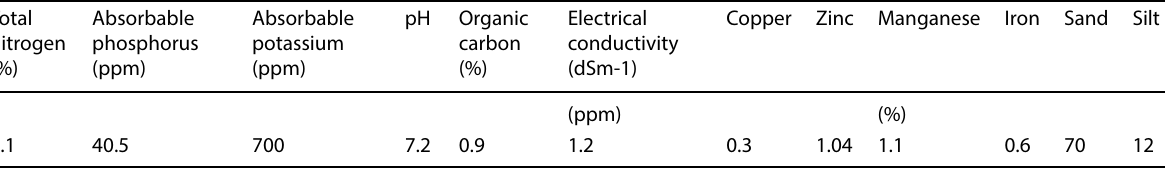
Table 2 Physical and chemical properties of the soil